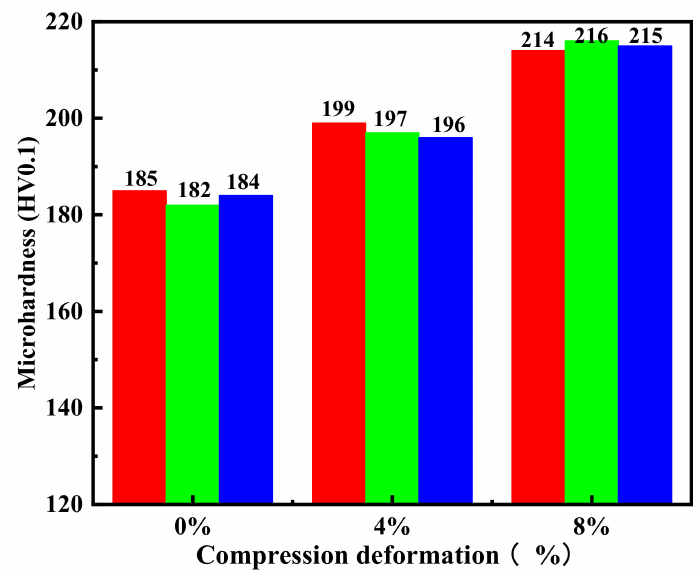
Figure 5. Microhardness values of samples at 0%, 4%, and 8% compressive